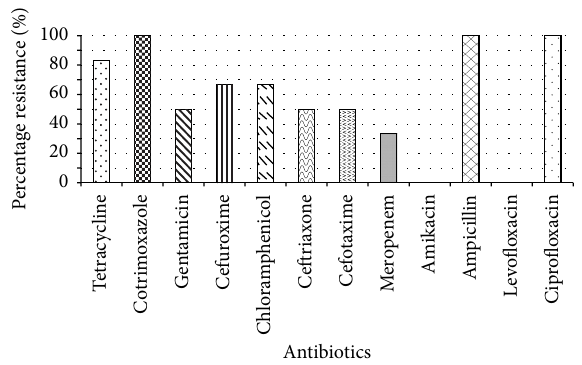
Figure 2: Percentage resistance of antibiotics tested. Six out of the eight isolates tested, namely, Salmonella species, Citrobacter species, Escherichia coli, Proteus mirabilis, Klebsiella pneumoniae ,and Kleb- siella oxytoca. The values of diameter (mm) measurement that were considered sensitive are as follows: tetracycline ≥ 26, cefotaxime ≥ 26, cotrimoxazole ≥ 24, ampicillin ≥ 17, gentamicin ≥ 20, ciprofloxacin ≥ 21, cefuroxime ≥ 18, meropenem ≥ 16, amikacin ≥ 20, chloramphenicol ≥ 30, ceftriaxone ≥ 21, and levofloxacin ≥